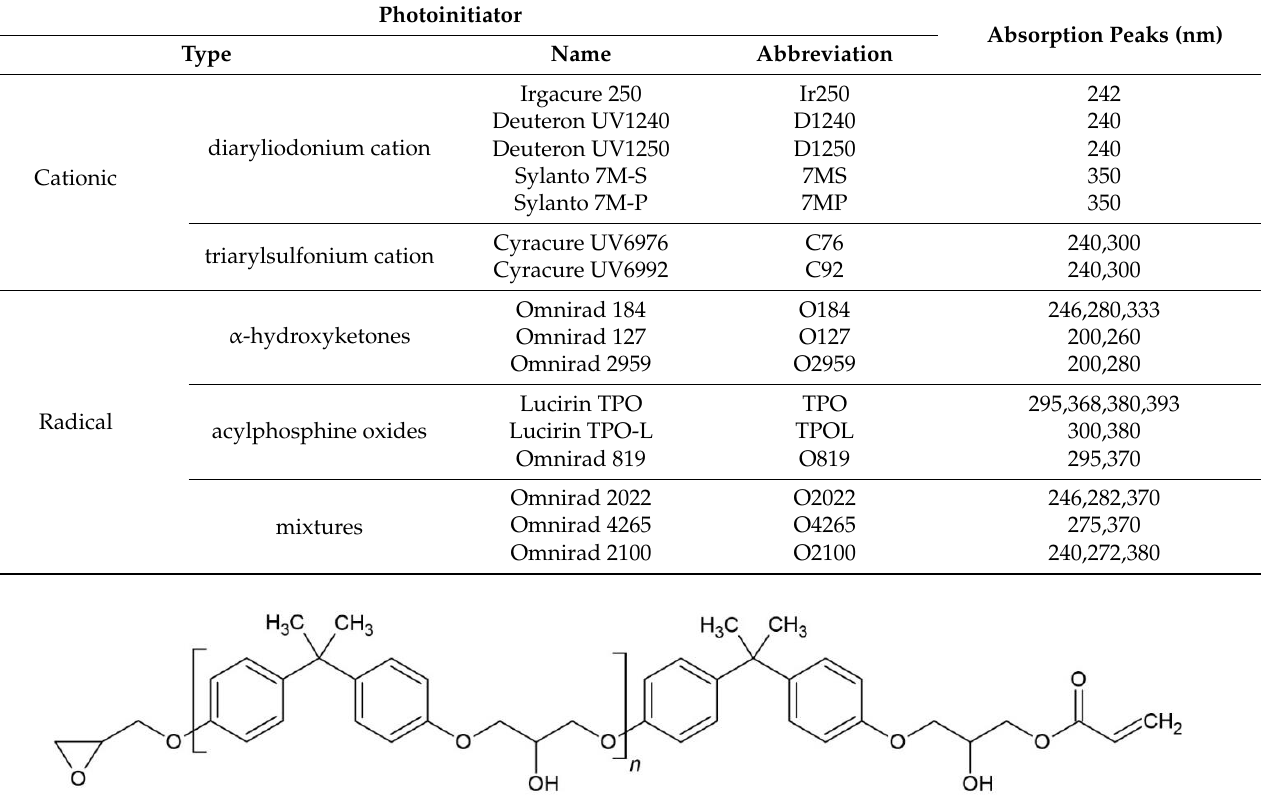
Figure 6. Structure of epoxy acrylate prepolymer.